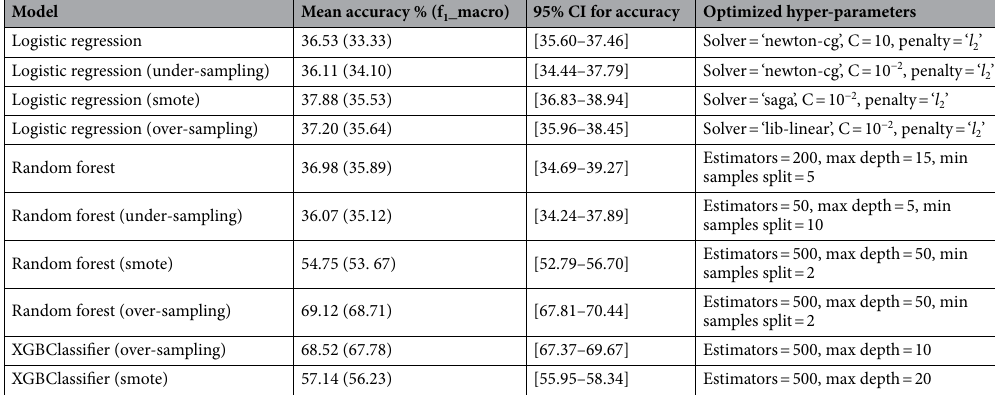
Table 2. Example of comparison models for the classification of six clusters obtained for the case of Physical Health (pre-injury) with HDclassif method.